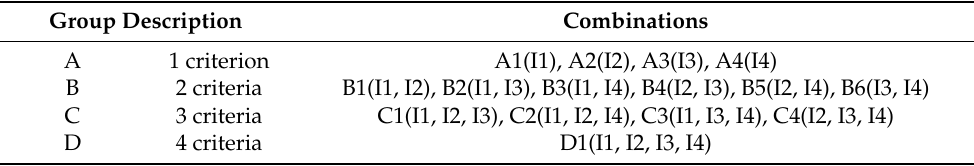
Table 5. Structure of the executed analysis depending on the number of assessed criteria. Group